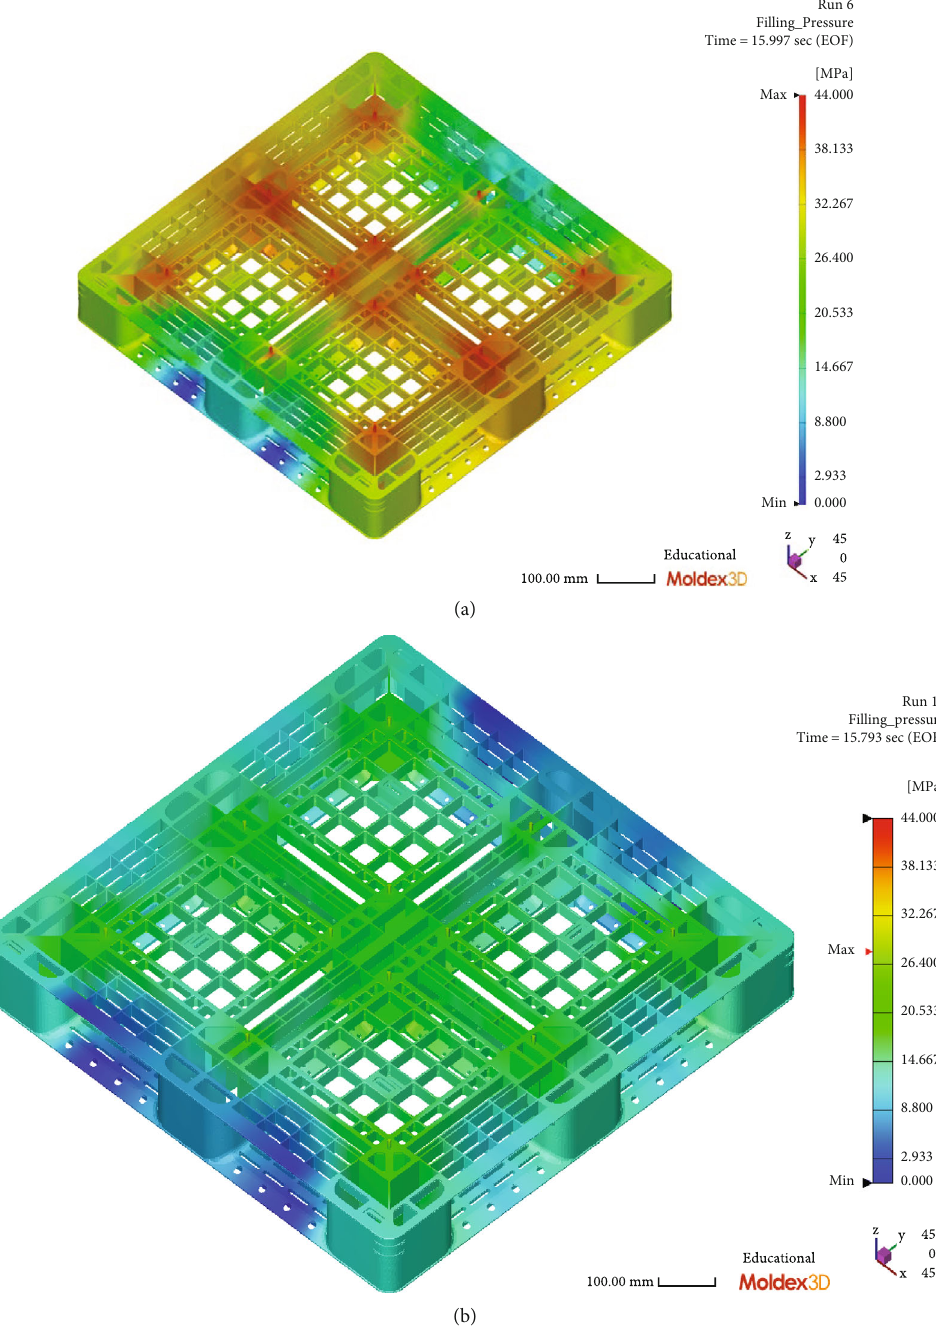
Figure 6: Filling pressure distribution within the mold cavity. (a) Concurrent valve gate opening. (b) Sequential gate